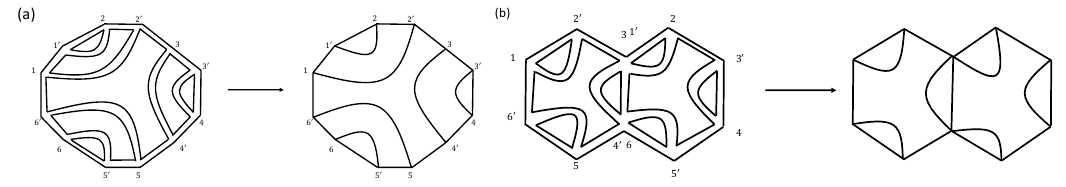
Figure 20 . For n = 6 and τ = (12)(34)(56) , we show the planar double-line diagrams and the corresponding polygons that we get for the first and third terms in the second line of (A.6), using the boundary conditions from (19) (a) and